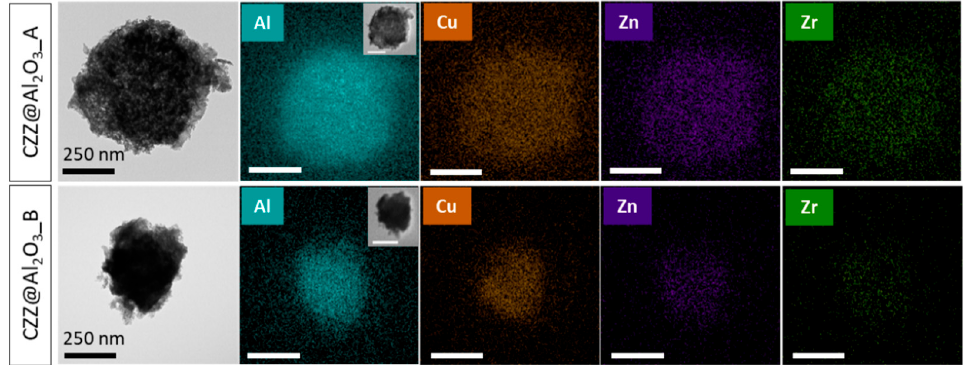
Figure 4. TEM-EDX chemical mapping of CZZ@Al 2 O 3 _A (upper part) and CZZ@Al 2 O 3 _B (lower part).